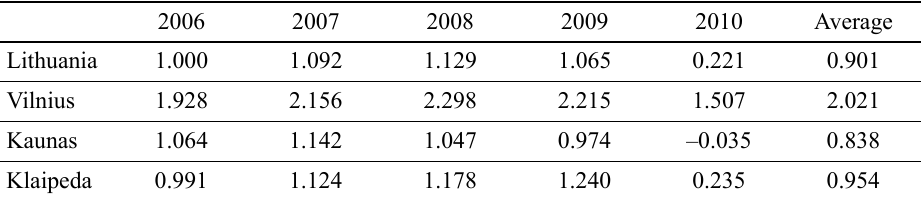
Table 2. The general intellectual capital balance